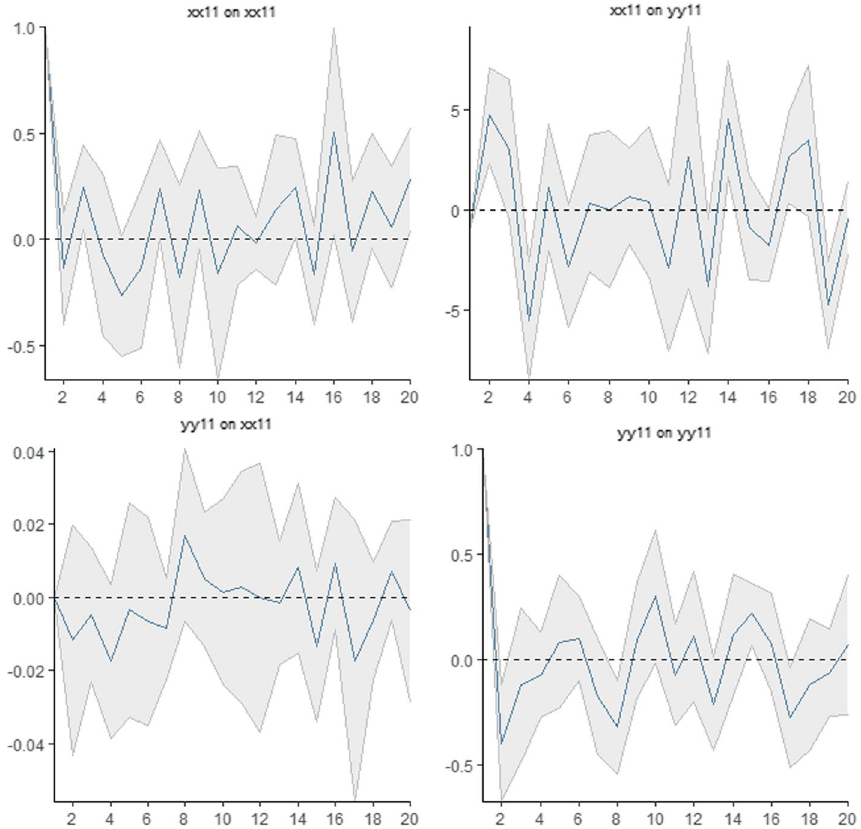
Fig. 10 The subperiod analysis of high-return regime for the period in which CPI > IR (Negative interest rates) (12.02.2019–05.12.2020). Note : Grey shaded area illustrates 95% confidence intervals. The figures from top to bottom correspond to linear analysis, low return regime, high return regime